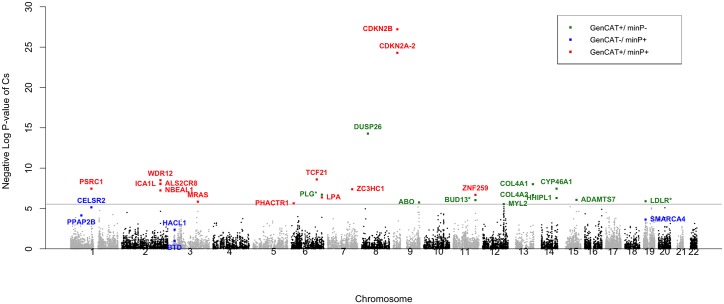
Manhattan plot illustrating GenCAT and minP protein-coding gene discoveries using CARDIoGRAM meta-analysis data.The horizontal line indicates the Bonferroni corrected threshold of 0.05/17280 = 2.89×10−06. Genes indicated with * are significant for GenCAT and negative for minP (GenCAT+/minP-) but are within 500Kb of a minP significant gene.